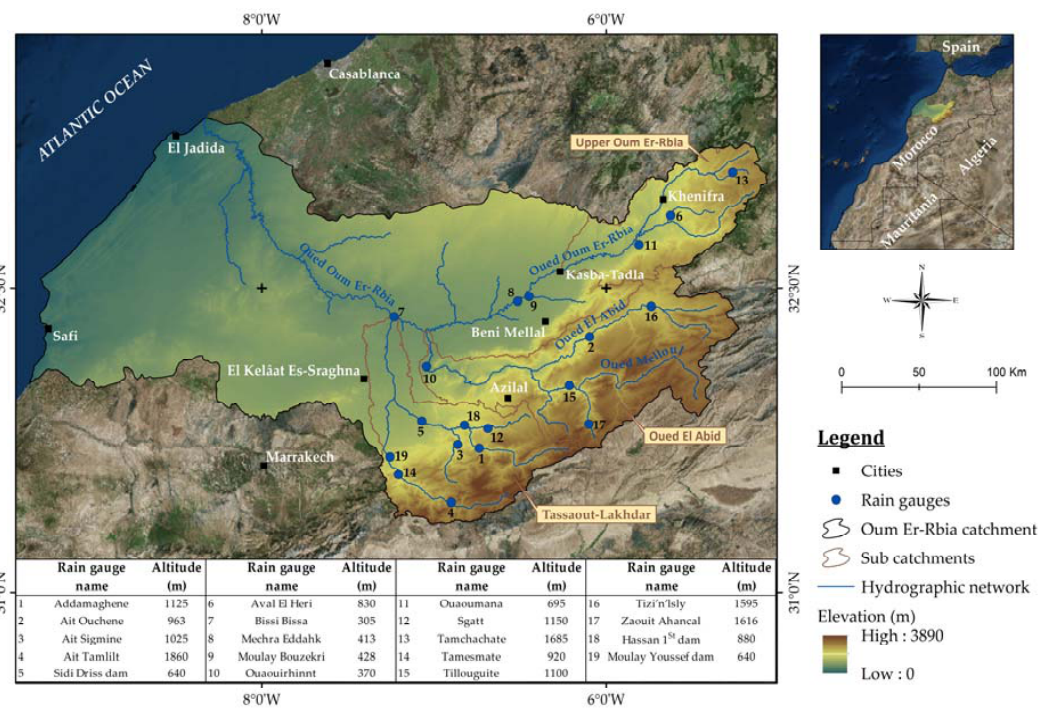
Figure 1. Geographical location of the study area and locations of used rain gauges.